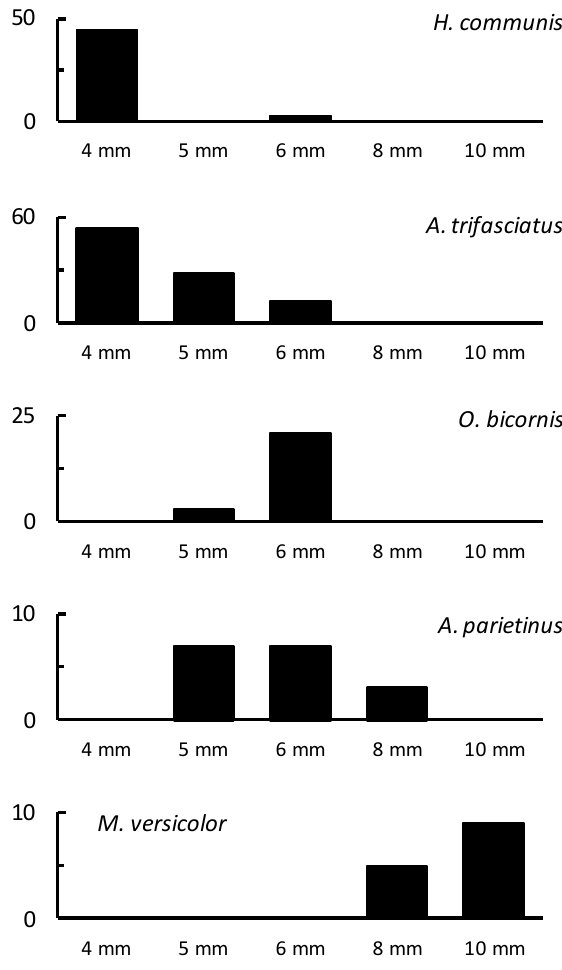
Figure 2. Distribution of nest tube diameters used by different species of stem-nesting Hymenoptera across 16 farmland sites in Ireland. Figures given are the total numbers of tubes used from 960 of each diameter. Species are presented in the order of their median nest tube